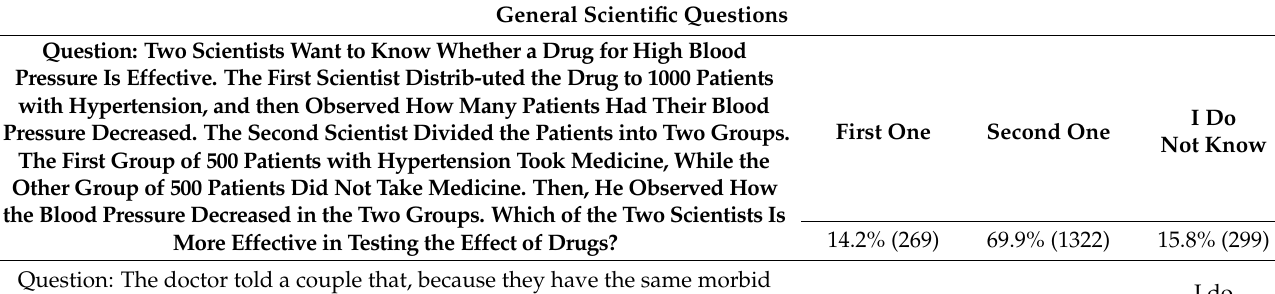
Table 4. Participants’ scientific literacy and knowledge about vaccine ( n =